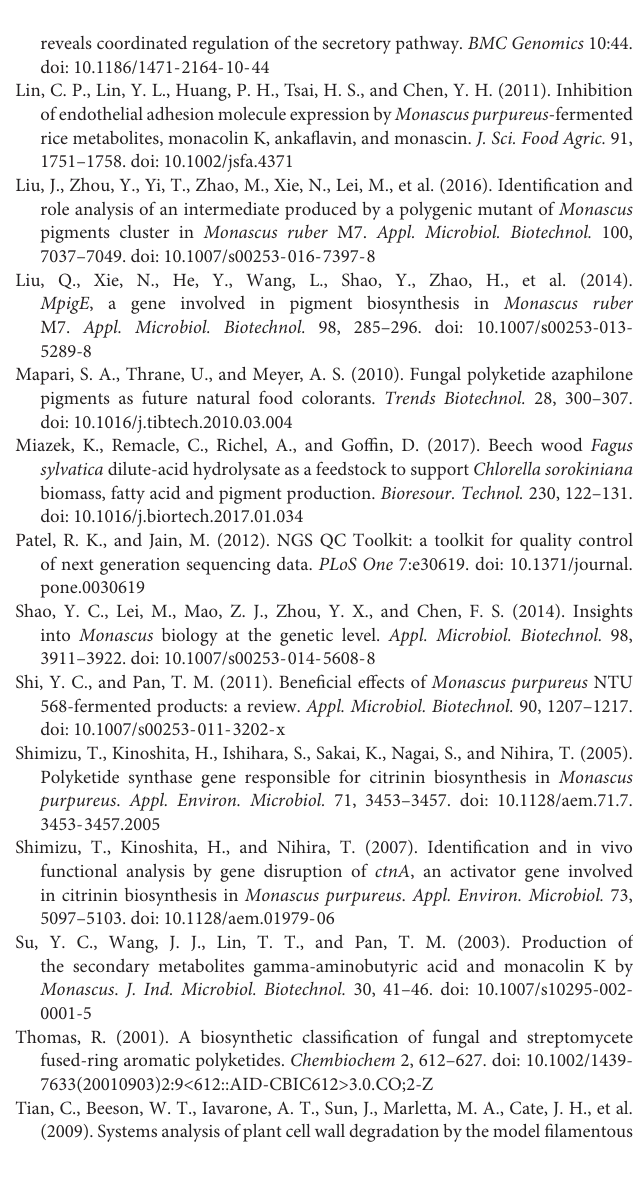
TABLE S2 | Gene ontology analysis of 1377 genes with up-regulated expression levels in M. purpureus winter. p -values highlighted in yellow indicate functional classifications that were significantly enriched. TABLE S3 | Gene ontology analysis of 1418 genes with down-regulated expression levels in M. purpureus winter. p-values highlighted in yellow indicate functional classifications that were significantly enriched. TABLE S4 | Genes involved in carbohydrate degradation was significantly decreased in M. purpureus winter, belonging to the cluster of carbohydrate metabolic process. TABLE S5 | Expression profile of transcription factor genes with differential transcriptional levels and more than two-fold charges in M. purpureus winter, compared to that in the YY-1 strain. TABLE S6 | The analysis of KEGG function enrichment of up-regulated genes in M. purpureus winter. p -values highlighted in yellow indicate functional classifications that were significantly enriched. TABLE S7 | RT-PCR Primers used in this